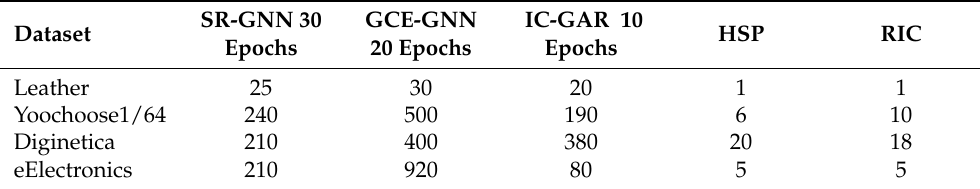
Table 5. The approximate experimentation execution time in